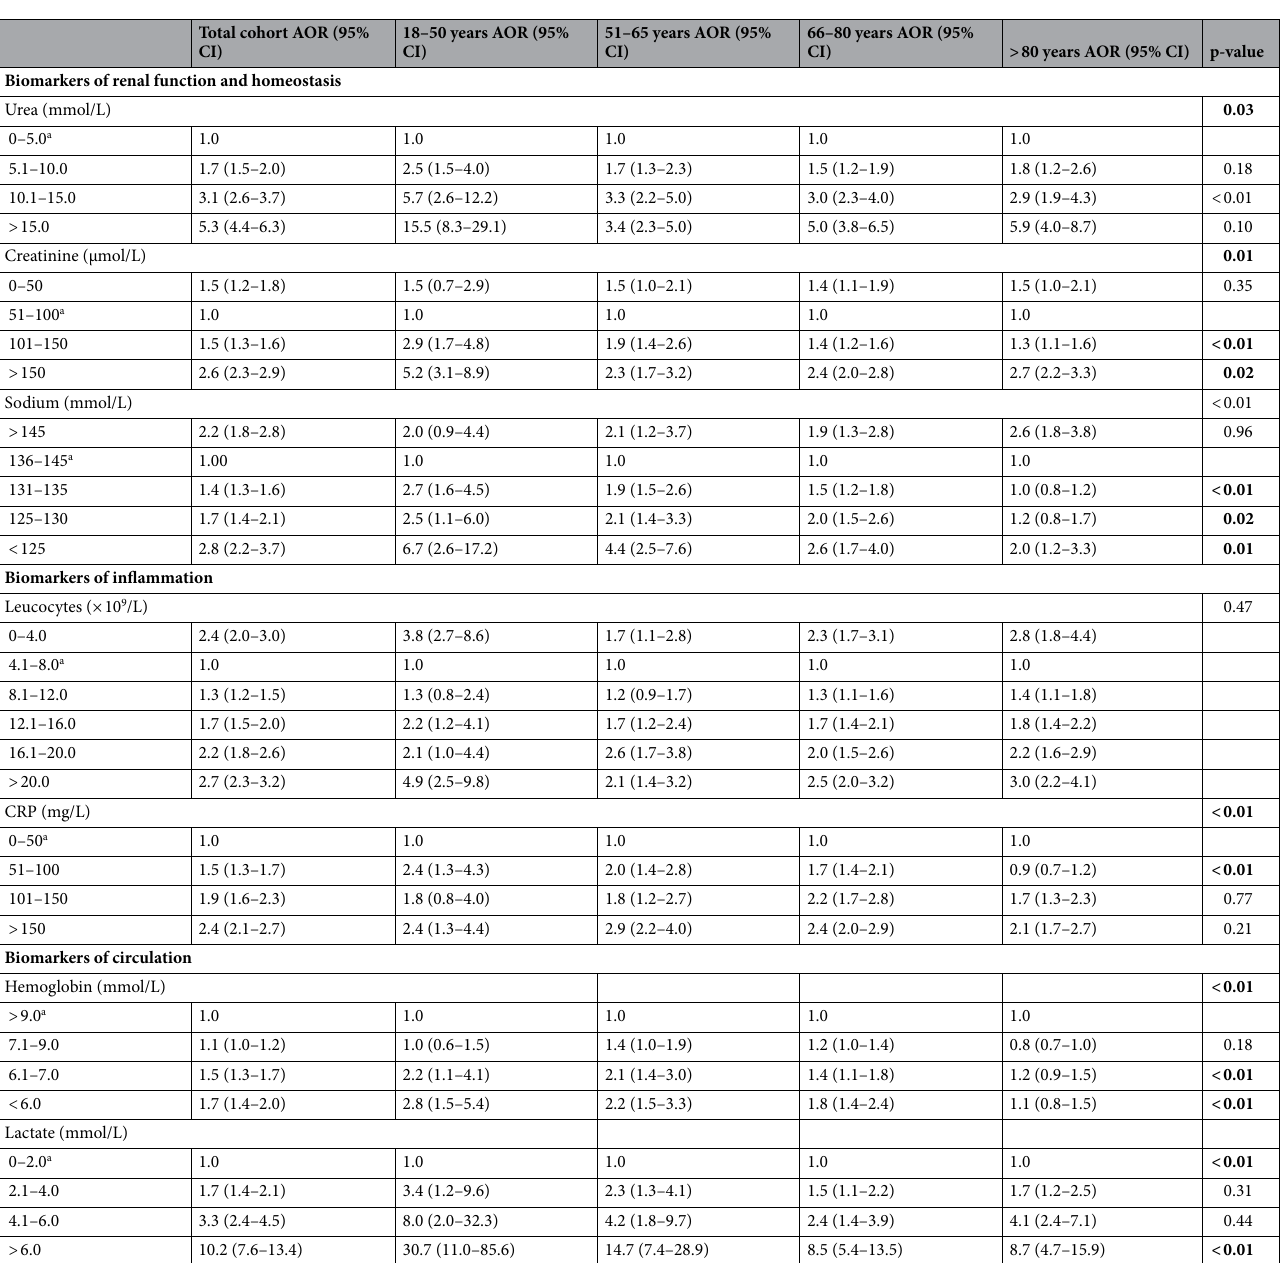
Table 2. Adjusted odds ratios with 95% confidence intervals for the association of categorized urea, creatinine, sodium, leukocytes, C-Reactive Protein, hemoglobin and lactate and in-hospital mortality in age-categories. The following potential confounders were entered in the model through backward stepwise regression: age, gender, triage category (green/blue, yellow, orange, red), top ten presenting complaints, hospital, systolic blood pressure, heart rate, peripheral oxygen saturation, high dependency care unit admission, number of consultations in the ED (0, 1, 2 or > 2), performed radiological tests and blood tests. Number of patients in the total cohort was for creatinine (N = 89,784), urea (N = 88,816), sodium (N = 91,617) and lactate (N = 13,717), leukocytes (N = 91,136), CRP (N = 78,085) and hemoglobin (N = 92,304). AOR Adjusted Odds Ratio, 95 CI 95% confidence interval, CRP C-reactive Protein. The p-value is presented from the interaction term of age*biomarker which was added in the analyses. Values in bold are statistically significant. a Used as reference category in the multivariable logistic regression